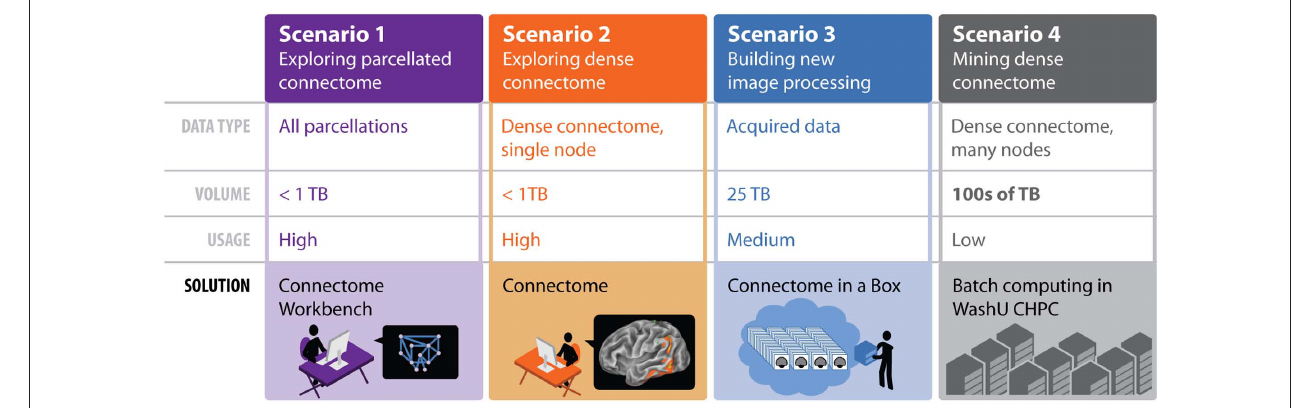
FIguRe 4 | HCP data distribution